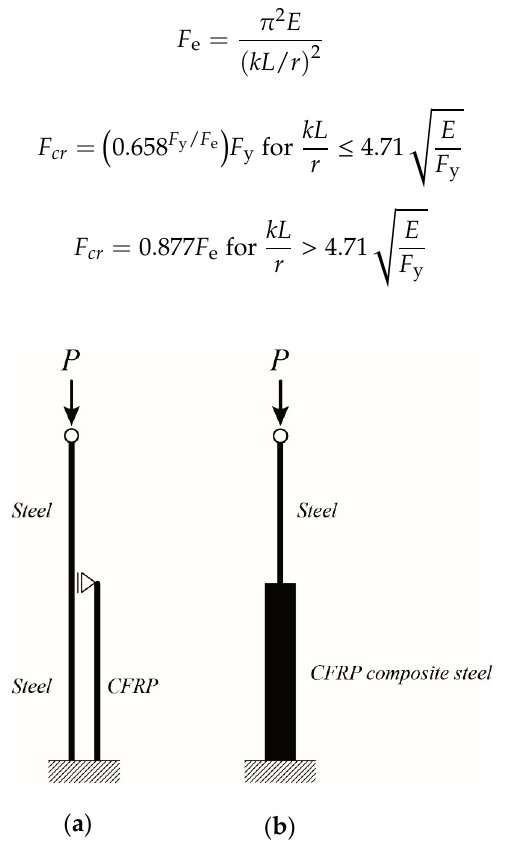
Figure 13. Structural model: ( a ) lower limit, ( b ) upper limit.